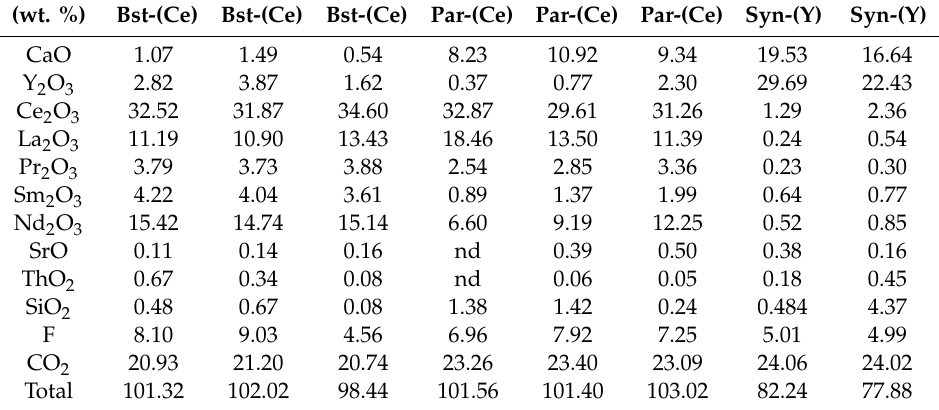
Table 6. Representative EPMA analysis of REE-carbonate minerals bastnaesite-(Ce), parisite-(Ce), and